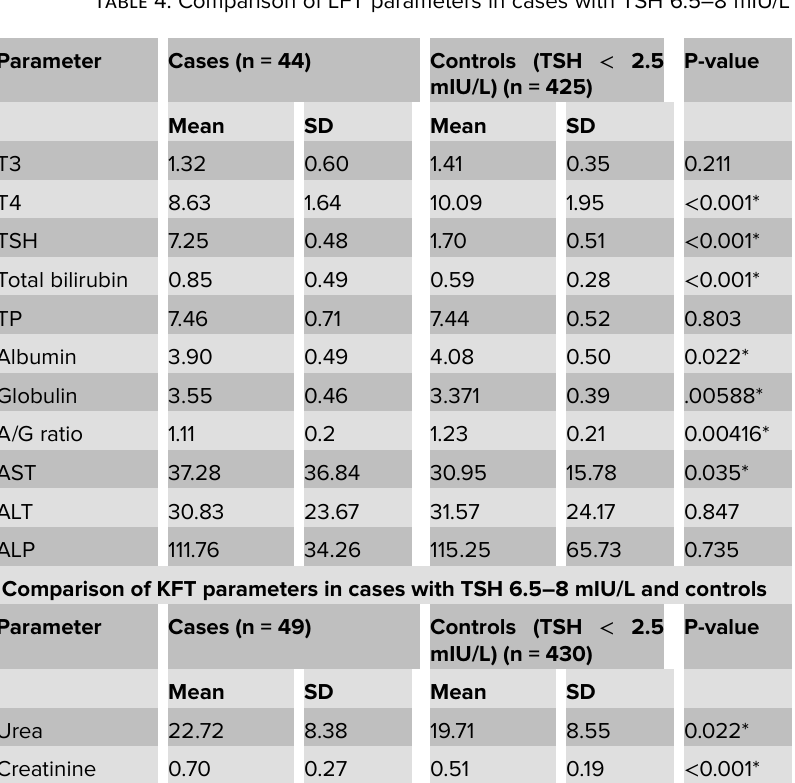
Table 5: Correlation of TSH with various parameters among study cases for TSH values 6.5–10 mIU/L. Parameter Pearson correlation P-value